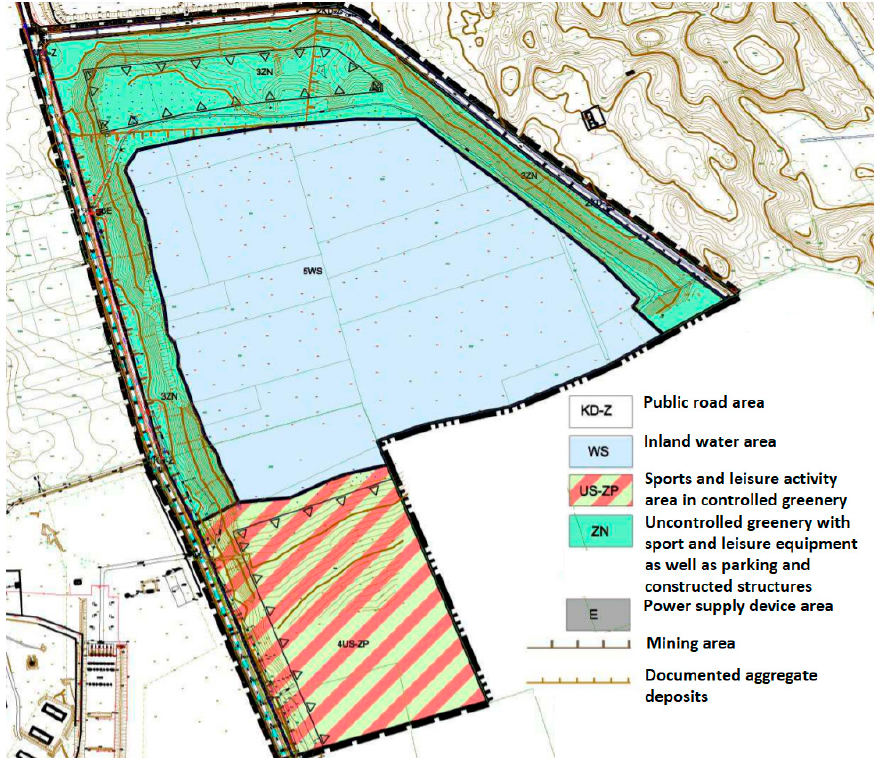
Figure 7. A fragment of the graphic attachment to the local area development plan for the post ‐ gravel pit area—Sobolewo reservoir. Source: Local area development plan for the post ‐ gravel pit area—Sobolewo reservoir in Suwałki. Table 1. Acceptable forms and elements of the area development for the post-gravel pit area—Sobolewo water reservoir in Suwa ł ki.